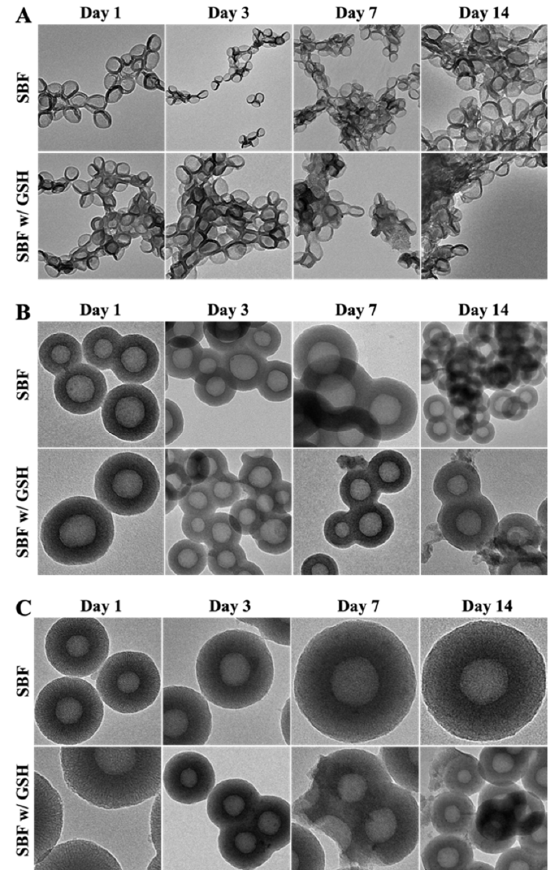
Figure 6. Degradation of layer ‐ by ‐ layer HMSNPs in SBF compared to SBF with GSH. TEM images for ( A ) H 1 , ( B ) H 2 , and ( C ) H 3 at days 1, 3, 7 and 14. H 2 and H 3 nanoparticles are visibly more degraded